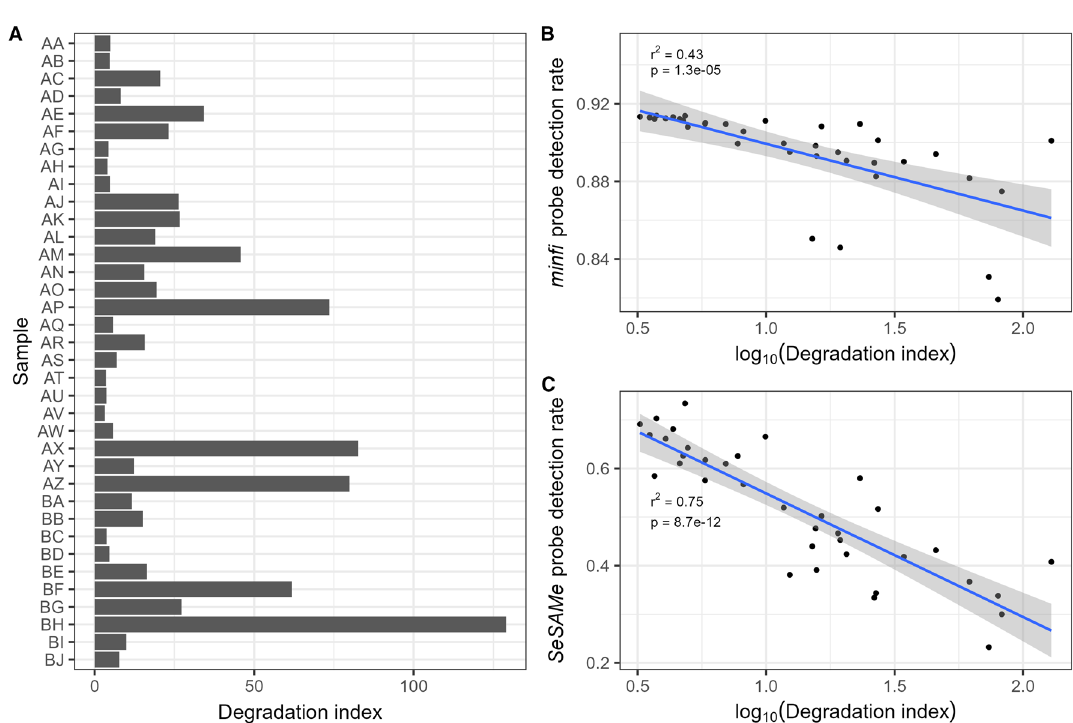
Figure 4. QuantifilerTrio measurements of the DNA quality. ( A ) Degradation index (DI) of each sample. ( B ) Correlation between DI and minfi probe DR The equation of the best fitting linear model was: ( DI ) ∗ 0.03 . ( C ) Correlation between DI and SeSAMe probe DR. The equation of minfi probeDR = 0.93 − log 10 the best fitting linear model was: SeSAMe probe DR = 0.80 − log 10 ( DI ) ∗ 0.25 . The grey areas in ( B ) and ( C ) indicate the 95% confidence